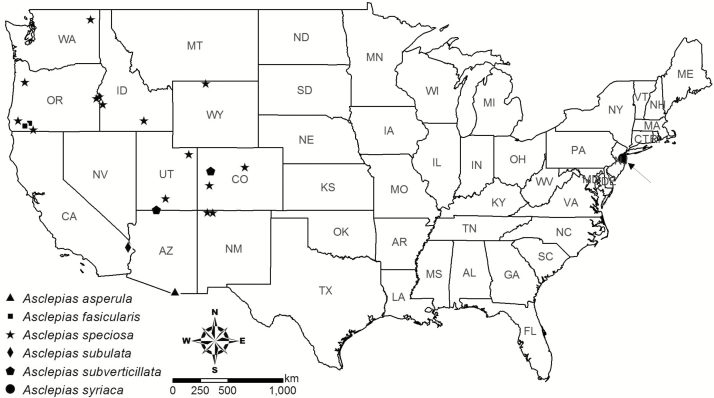
Location in the USA of each Asclepias source population included in this study. The arrow indicates a population of A. syriaca from New Jersey.